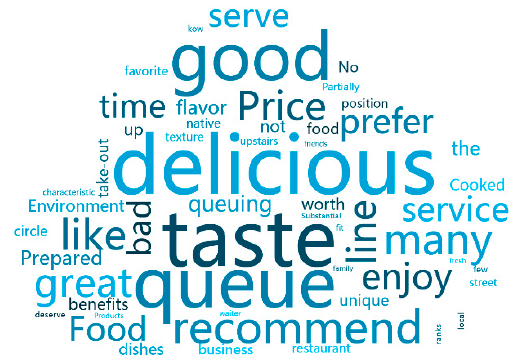
Figure 2. Word cloud before COVID-19.